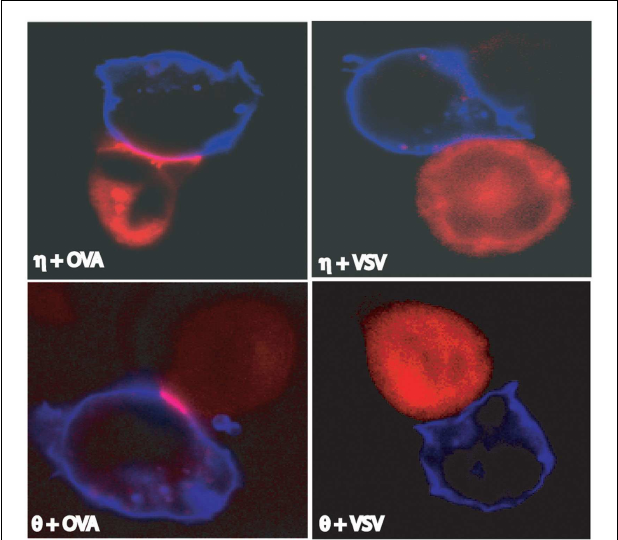
FIGURE 3 | Recruitment of PKC η and PKC θ to the immunological synapse. Both PKC η and PKC θ were recruited to the immunological synapse by antigenic stimulation (i.e., with stimulatory peptide OVA) but not by non-antigenic stimulation (i.e., with non-stimulatory peptideVSV). Blue are EL4 cells used as antigen-presenting-cells. Red are OT-IT hybridoma cells transfected with PKC η - or PKC θ -RFP as indicated. Adapted from Fu et al.